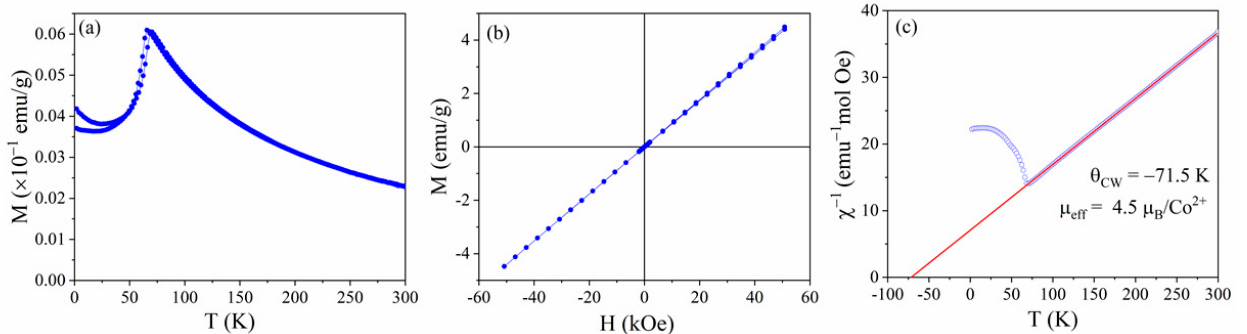
Figure 5. ( a ) Temperature dependence of the magnetization (M) in the field of 50 Oe of Co 2 (TeO 3 ) 2 (OH) 2 . ( b ) M versus H at 2 K. ( c ) Inverse susceptibility ( χ − 1 ) versus T